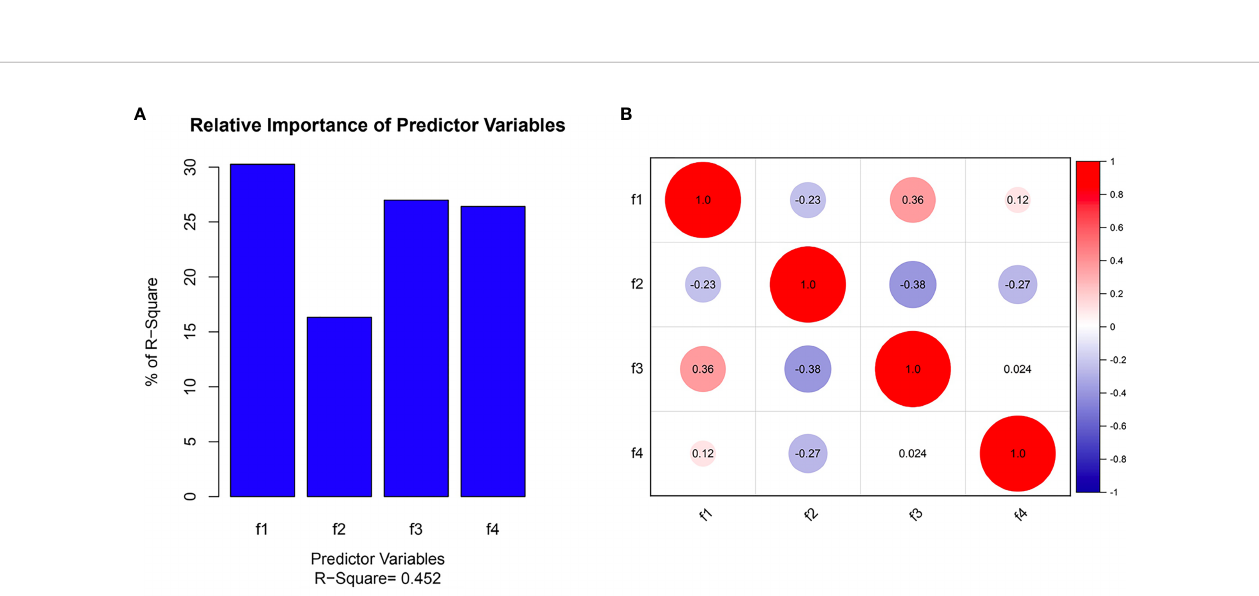
FIGURE 3 | Selected features in the PET/CT-Rad model predicting IDH mutation. (A) Feature importance of selected features; (B) correlation heatmap of selected features. f1, CT_glcm_InverseVariance; f2, CT_glrlm_LowGrayLevelRunEmphasis; f3, CT_gldm_DependenceVariance; f4,